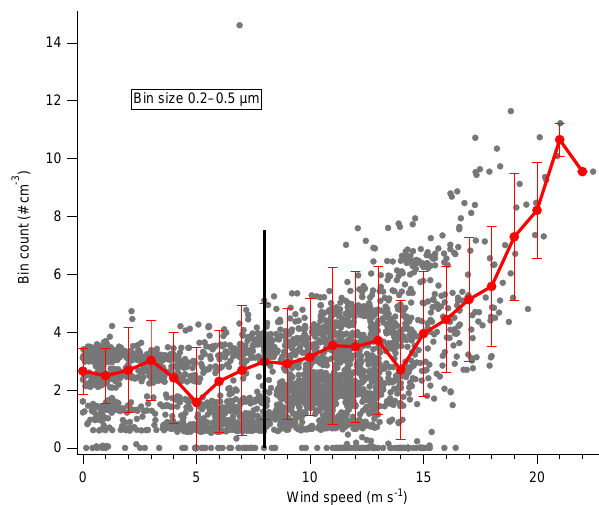
Figure 4. Laser disdrometer snow particle number counts per 10s with standard deviation, made at 5m above snow surface, as a func- tion of wind speed.